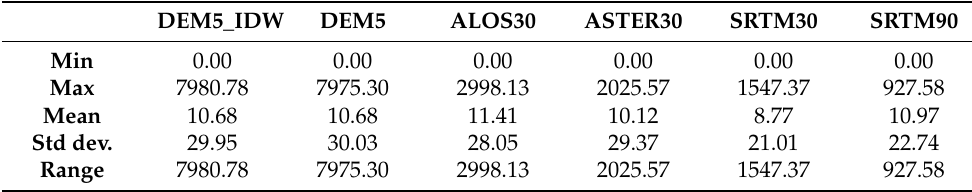
Table 7. The descriptive statistics of LS (MIT method) for all